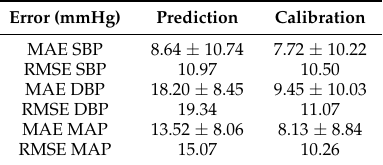
Table 10. Results